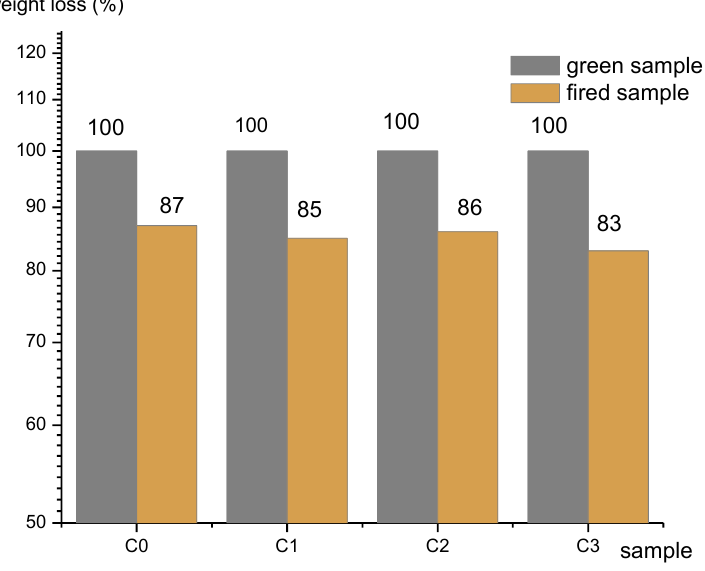
Figure 5. Weight of green and fired clay samples.